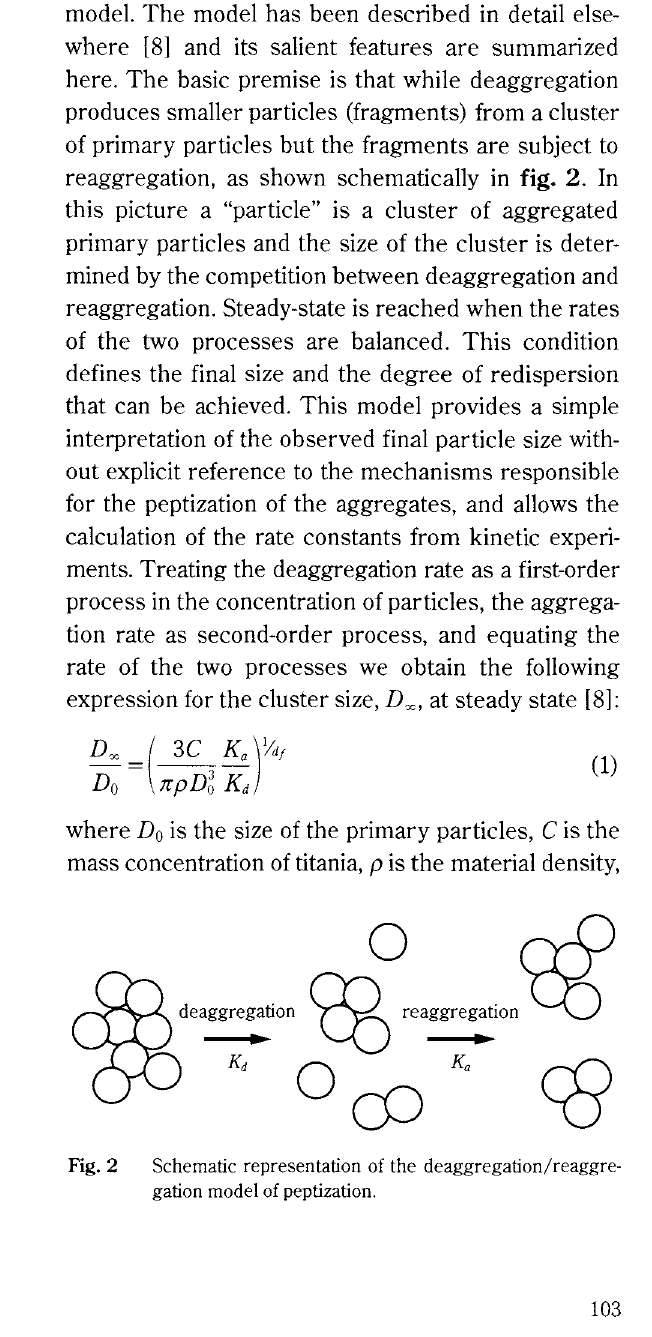
Schematic representation of the deaggregation/reaggre gation model of